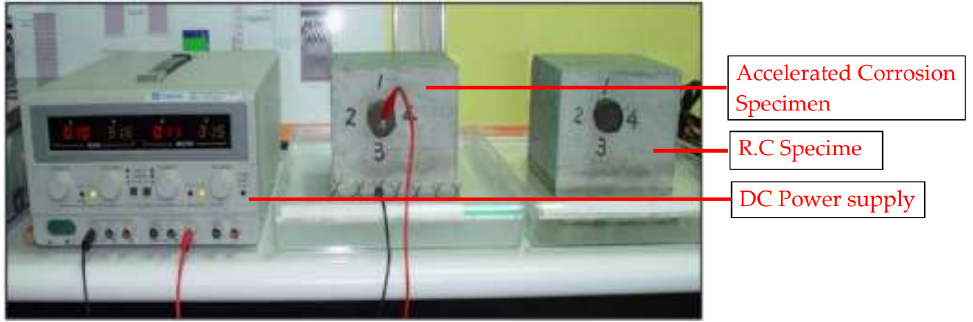
Figure 6. Accelerated Corrosion Test.